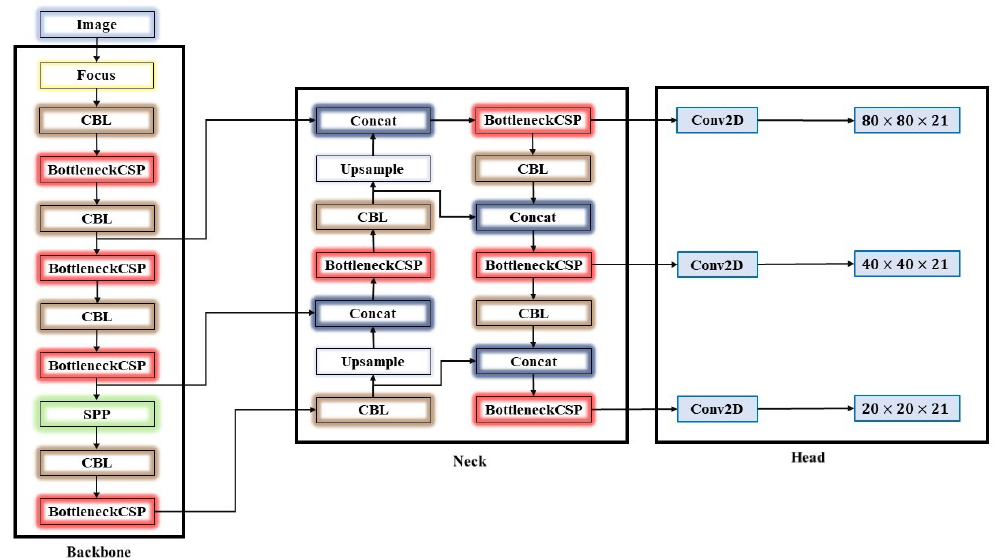
Figure 3. The YOLOv5 network framework.